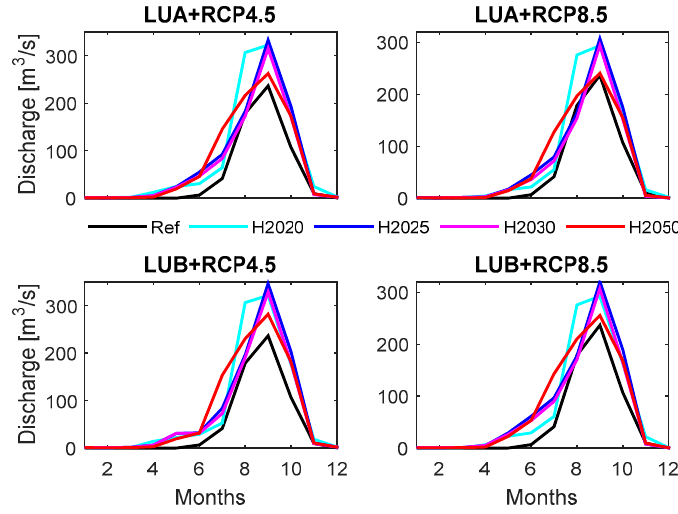
Figure 9. Monthly mean discharge scenarios based on climate and land use/cover combined scenarios.